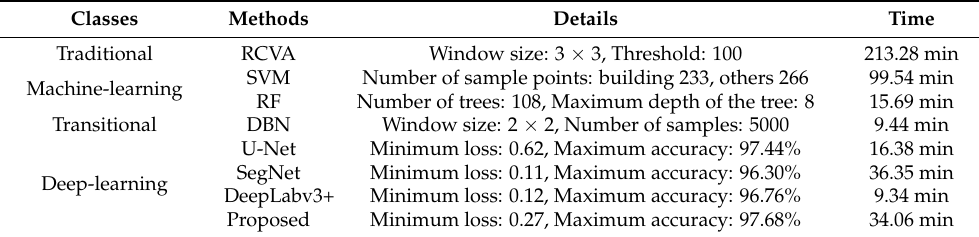
Table 2. Details of experiment 1.